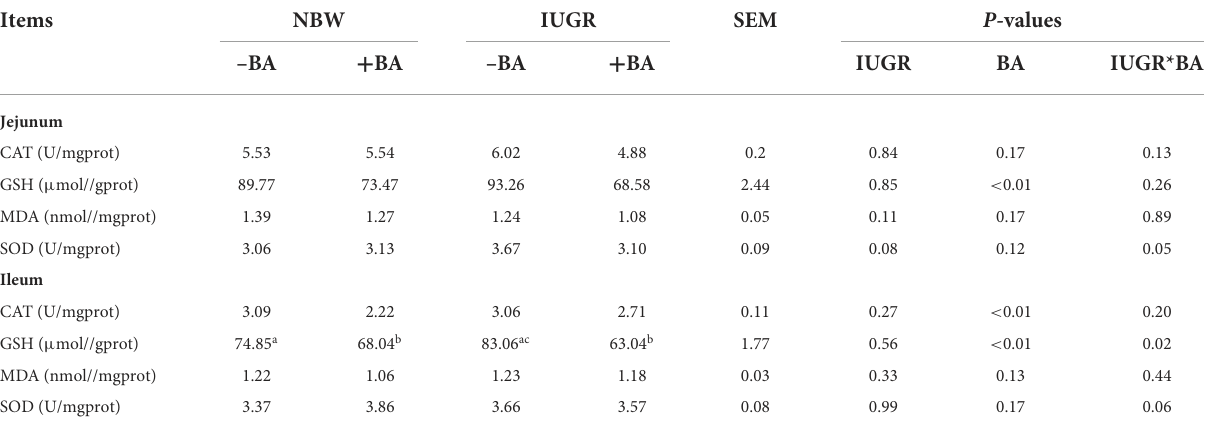
TABLE 7 Effects of dietary bile acid (BA) supplementation on the small intestine oxidant/antioxidant indices in weaned piglets with NBW and